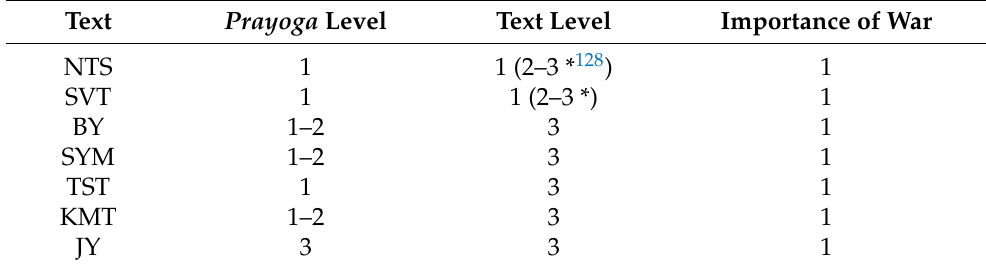
Table 1. The degree of transgression in war prayogas in the tantric texts compared to the overall character of each text and the importance of war-related